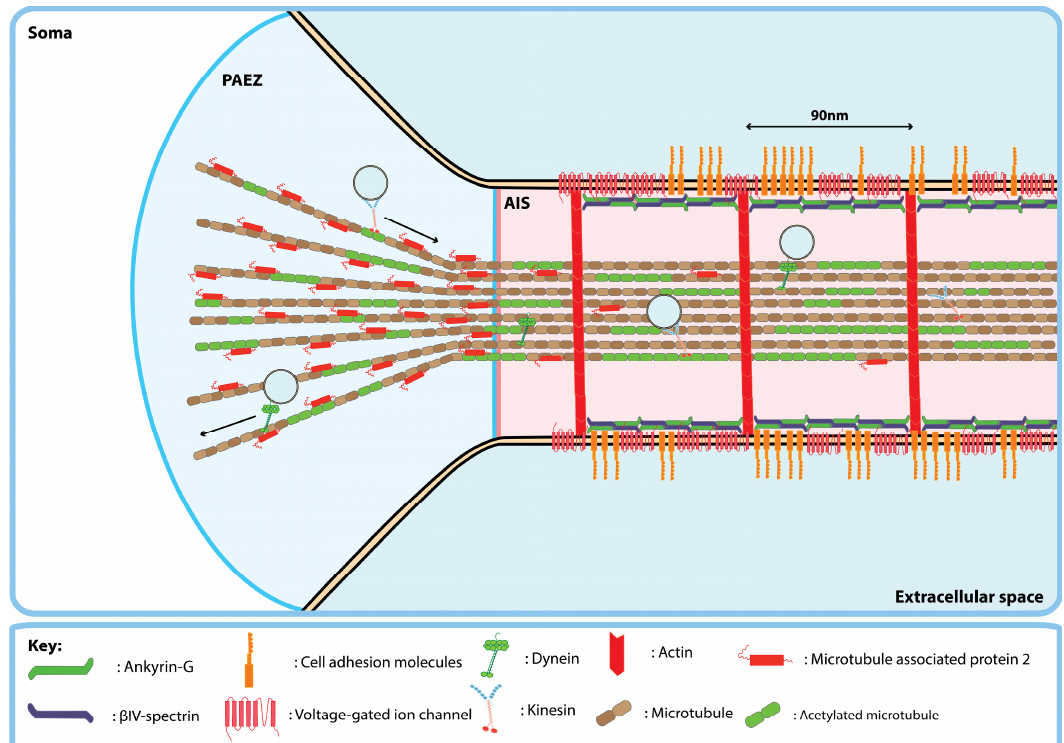
Figure 1. Organisation of the pre-axonal exclusion zone (PAEZ) and axon initial segment (AIS) of mature central nervous system neurons. The PAEZ is located within the soma just proximal to the AIS. In the axon, the majority of microtubules are oriented with the plus-end pointing away from the soma. Plus-end directed kinesins drive anterograde transport and minus-end directed dyneins drive retrograde axonal transport of transmembrane proteins. The AIS is found in the axon hillock and is marked by a unique molecular architecture consisting of periodic rings of f-actin and a submembrane undercoat composed of ankyrin-G and β IV-spectrin. Furthermore, the AIS membrane is densely packed with transmembrane proteins such as voltage-gated ion channels and cell adhesion